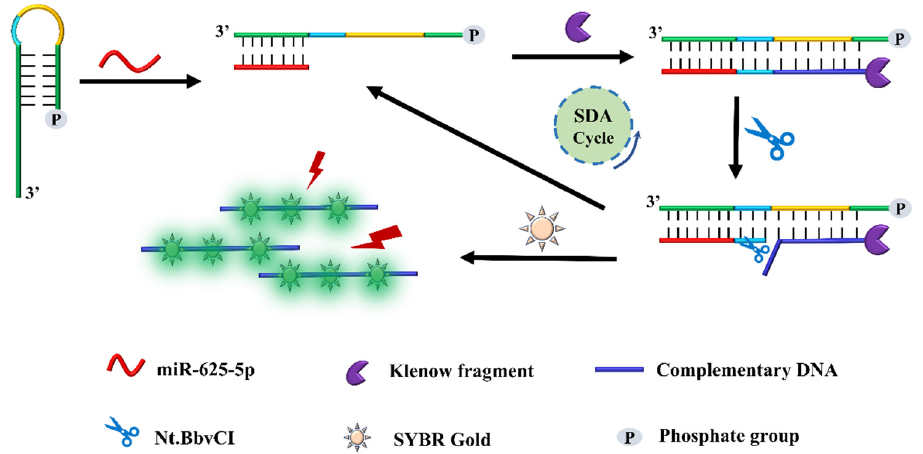
Figure 3. The principle of our detection method based on strand displacement amplification and SYBR Gold. miR-625-5p acts as a primer to open the stem loop of the hairpin and generate many complementary DNAs followed by the addition of KF polymerase, Nt.BbvCI enzyme and dNTPs. The complementary DNAs can be detected by SYBR Gold. The sequences of the hairpin and miR-625-5p can be seen in Table 1.